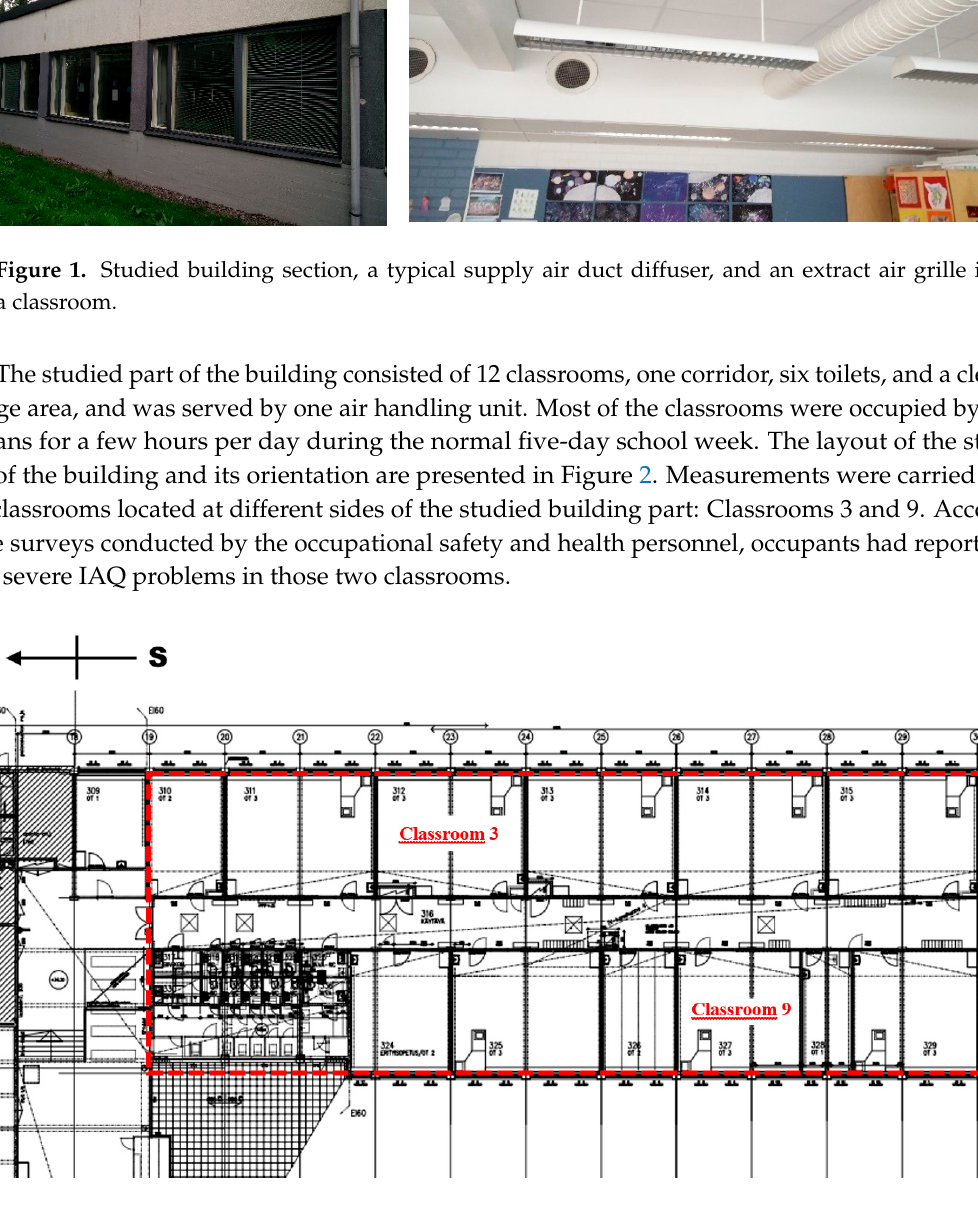
Figure 2. The ventilation intervention was conducted in the building section marked with red. Measurements were carried out in Classrooms 3 and 9.